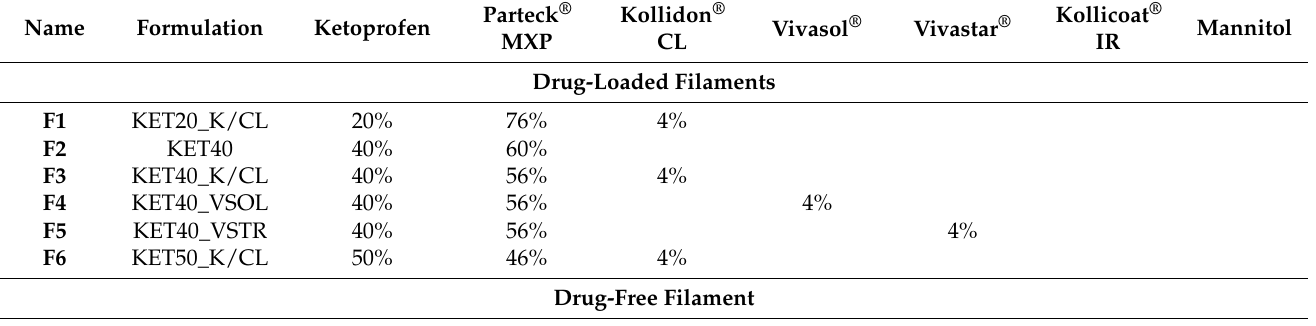
Table 5. Composition of the filaments.